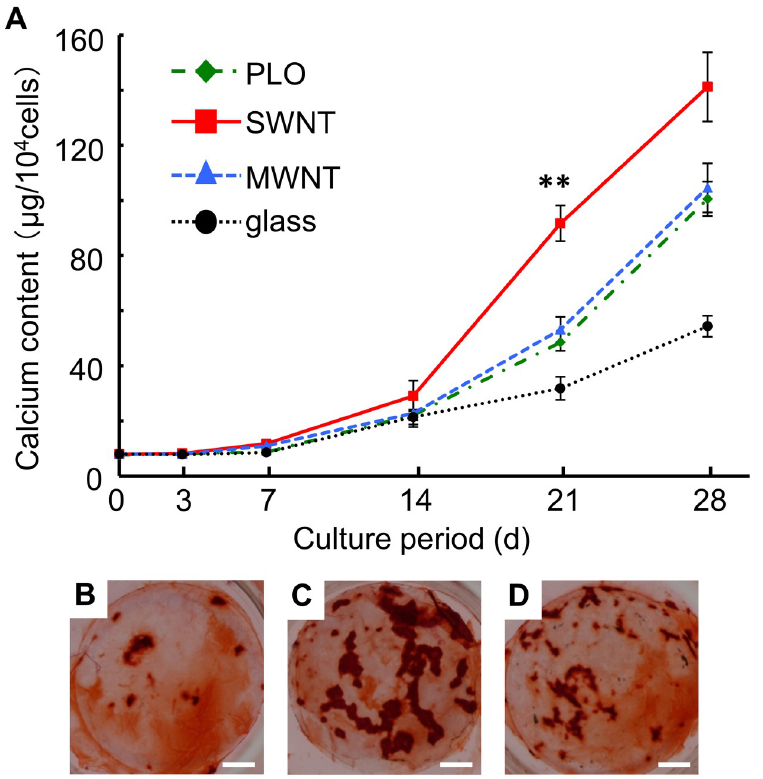
Fig 6. Calcium phosphate deposited by MSCs during osteogenic differentiation. Cells were cultured in osteogenic differentiation medium for 28 days. (A) Calcium contents normalized by cell numbers were measured at day 3, 7, 14, 21, and 28. The data are presented as mean ± S.D., n = 6 ( �� : p < 0.01). In addition, alizarin red-stained cells are shown on (B) PLO-, (C) SWNT-, (D) MWNT-coated glass at day 28. Scale bar: 2 mm.